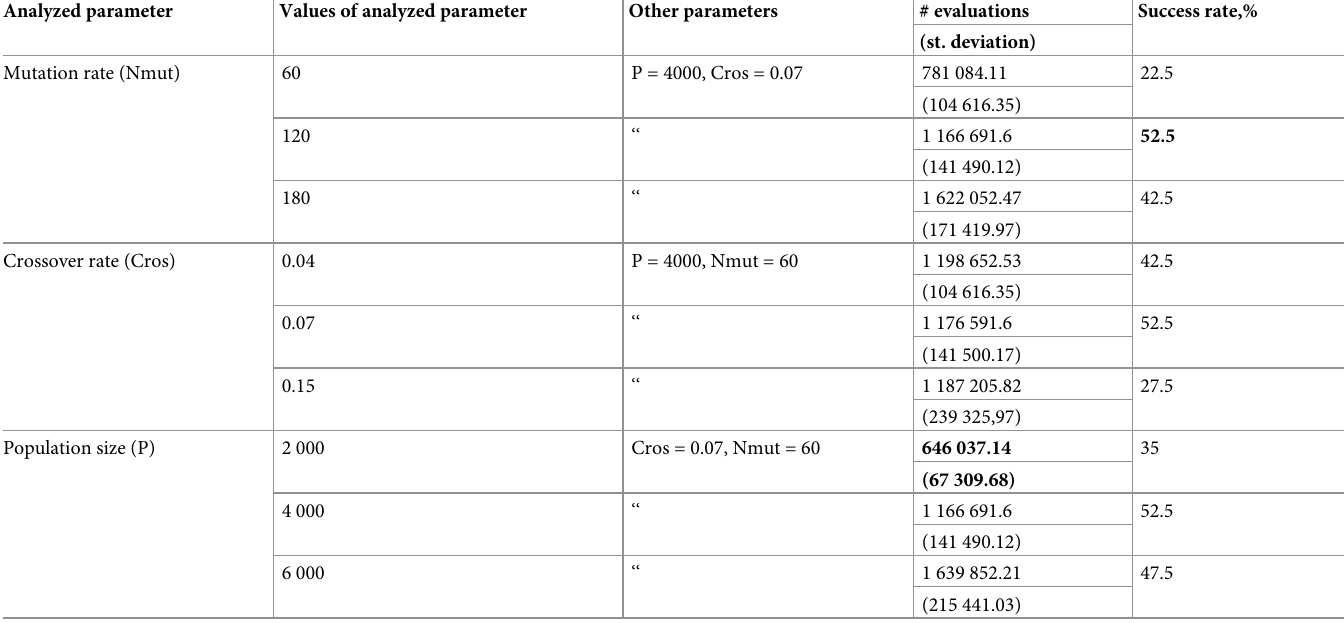
Table 3. Effect of the recombination of segments.